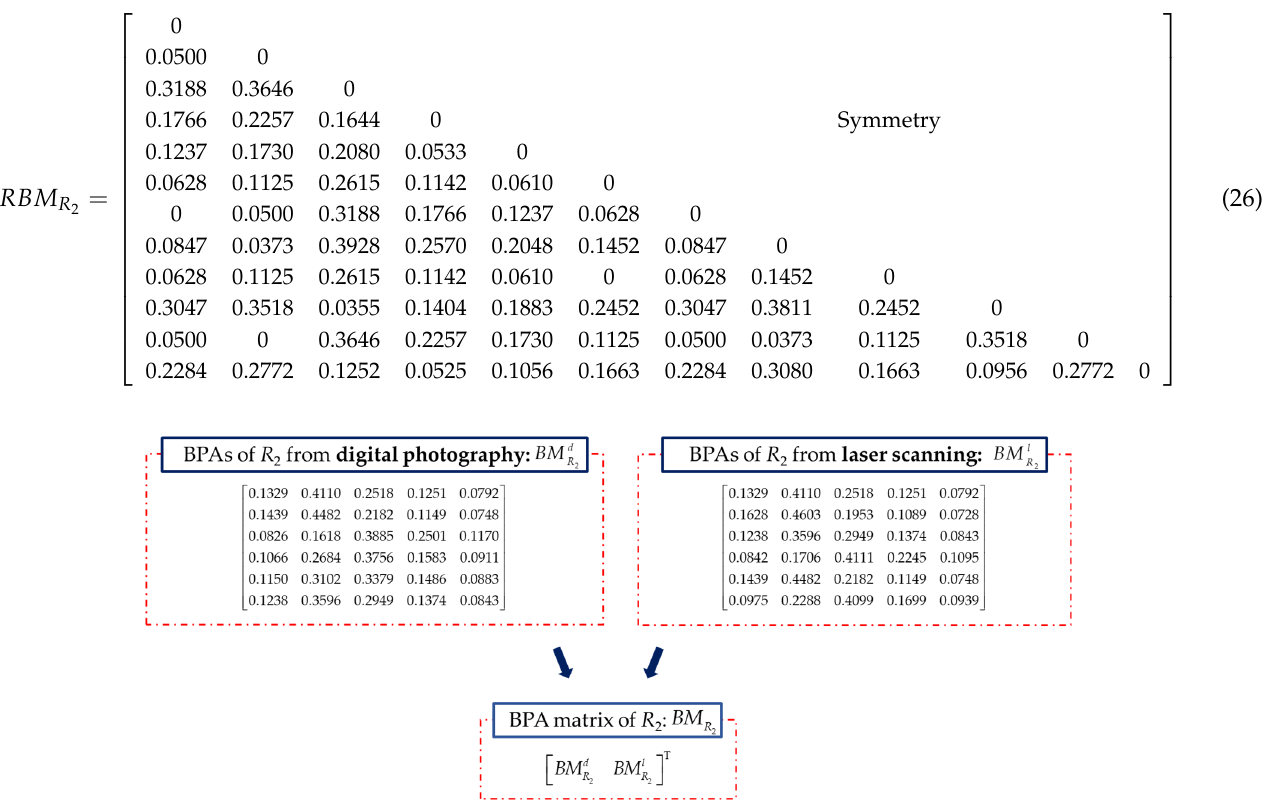
Figure 8. Initial fusion results of each rock mass index ( R 1 – R 5 ). ( a ) Initial fusion result of R 1 . ( b ) Initial fusion result of R 2 . ( c ) Initial fusion result of R 3 . ( d ) Initial fusion result of R 4 . ( e ) Initial fusion result of R 5 . Rock mass index R 2 is rated by the spacing of discontinuities, which is obtained by digital photography, and laser scanning. The excavation face is divided into several sampling windows, and the discontinuity information is extracted from the sampling windows to obtain the required data. The spacing of discontinuities is based on the BM is constructed based on the BPAs of R 2 number of discontinuities per unit length. 2 R RBM in Figure 9. 2 R